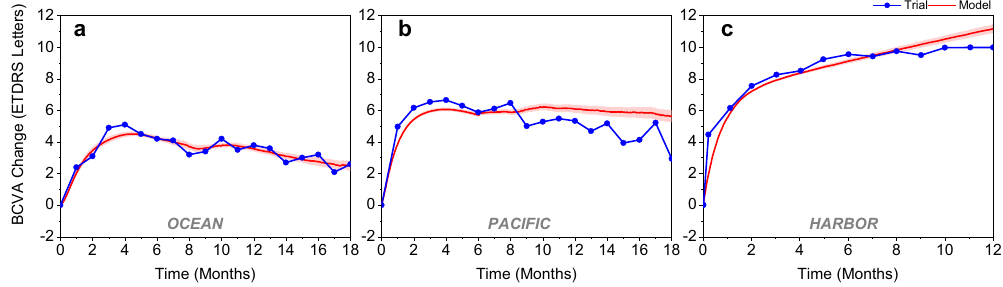
Figure 2. Mean BCVA change from baseline: model prediction with 95% prediction interval (red) versus observed data (blue) for ( a ) the trainings dataset OCEAN, ( b ) the non-interventional study validation dataset PACIFIC, and ( c ) the randomized controlled trial validation dataset HARBOR. BCVA = best corrected visual